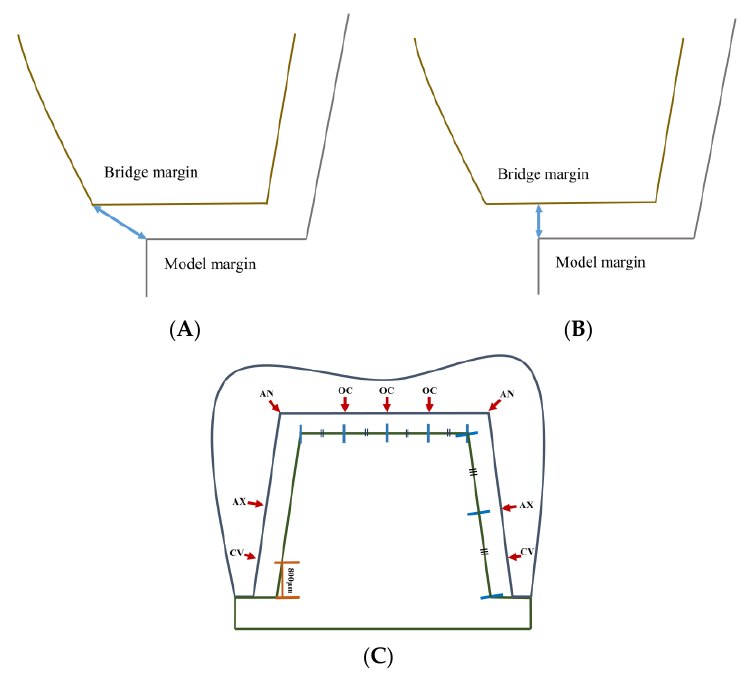
Figure 5. ( A ) The absolute marginal discrepancy (AMD) and ( B ) The marginal gap (MG) were measured for marginal fit. ( C ) The location of the internal gap length measurement points. Cervical area (CV) was measured at a height of 800 µm from the margin. Axial wall area (AX) was measured at mid-point of axial wall. Axio-occlusal angle area (AN) was measured at axio-occlusal angle. Occlusal area (OC) was measured at quadrants of occlusal plane.